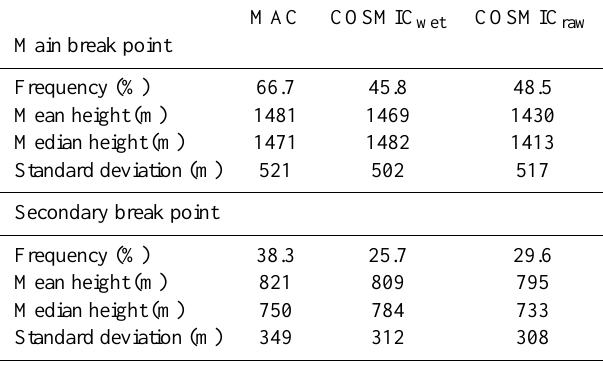
Table 3. Statistics for the main and secondary break point in the re- fractivity profile for the MAC, COSMIC wet and COSMIC raw prod- ucts.